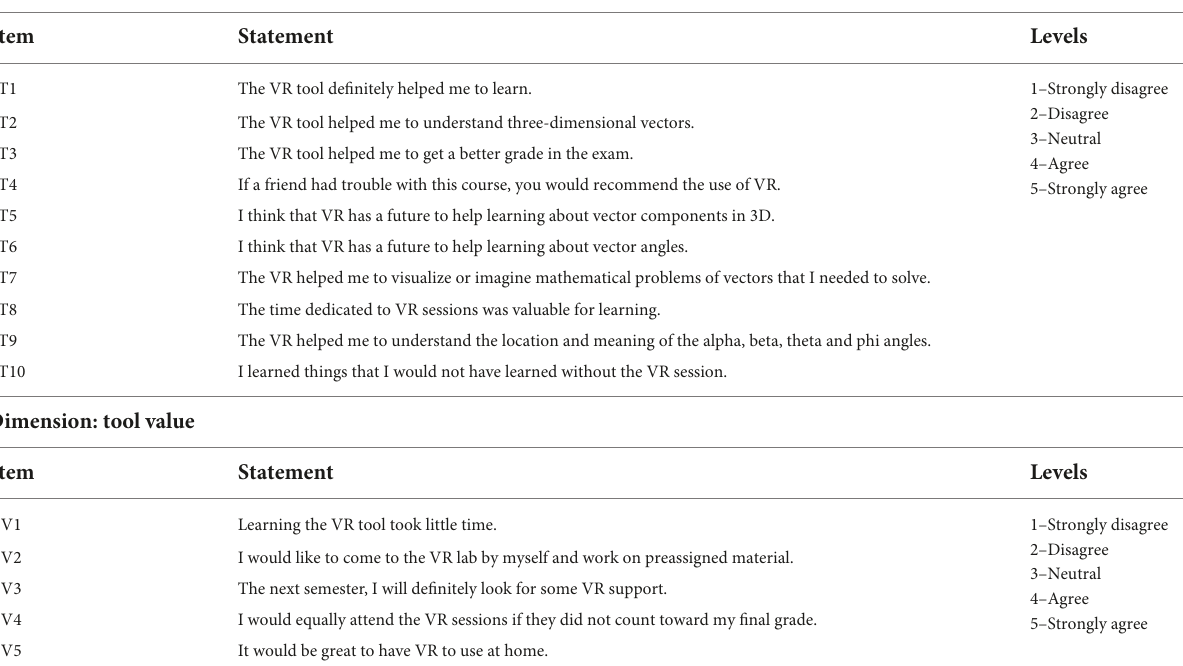
TABLE 3 Likert-scale questions related to students’ learning objectives and experience using virtual reality (VR). Dimension: learning